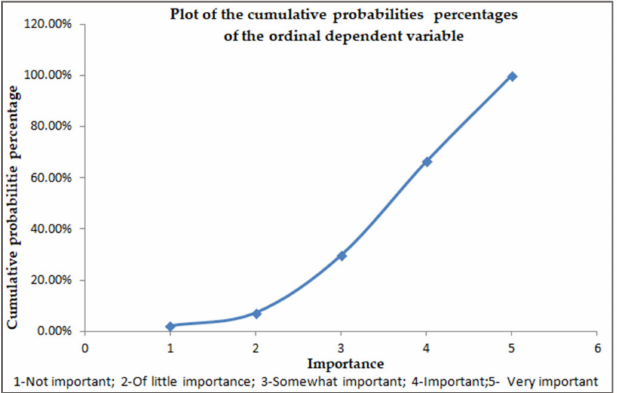
Figure 4. The cumulative probabilities percentages of the ordinal dependent